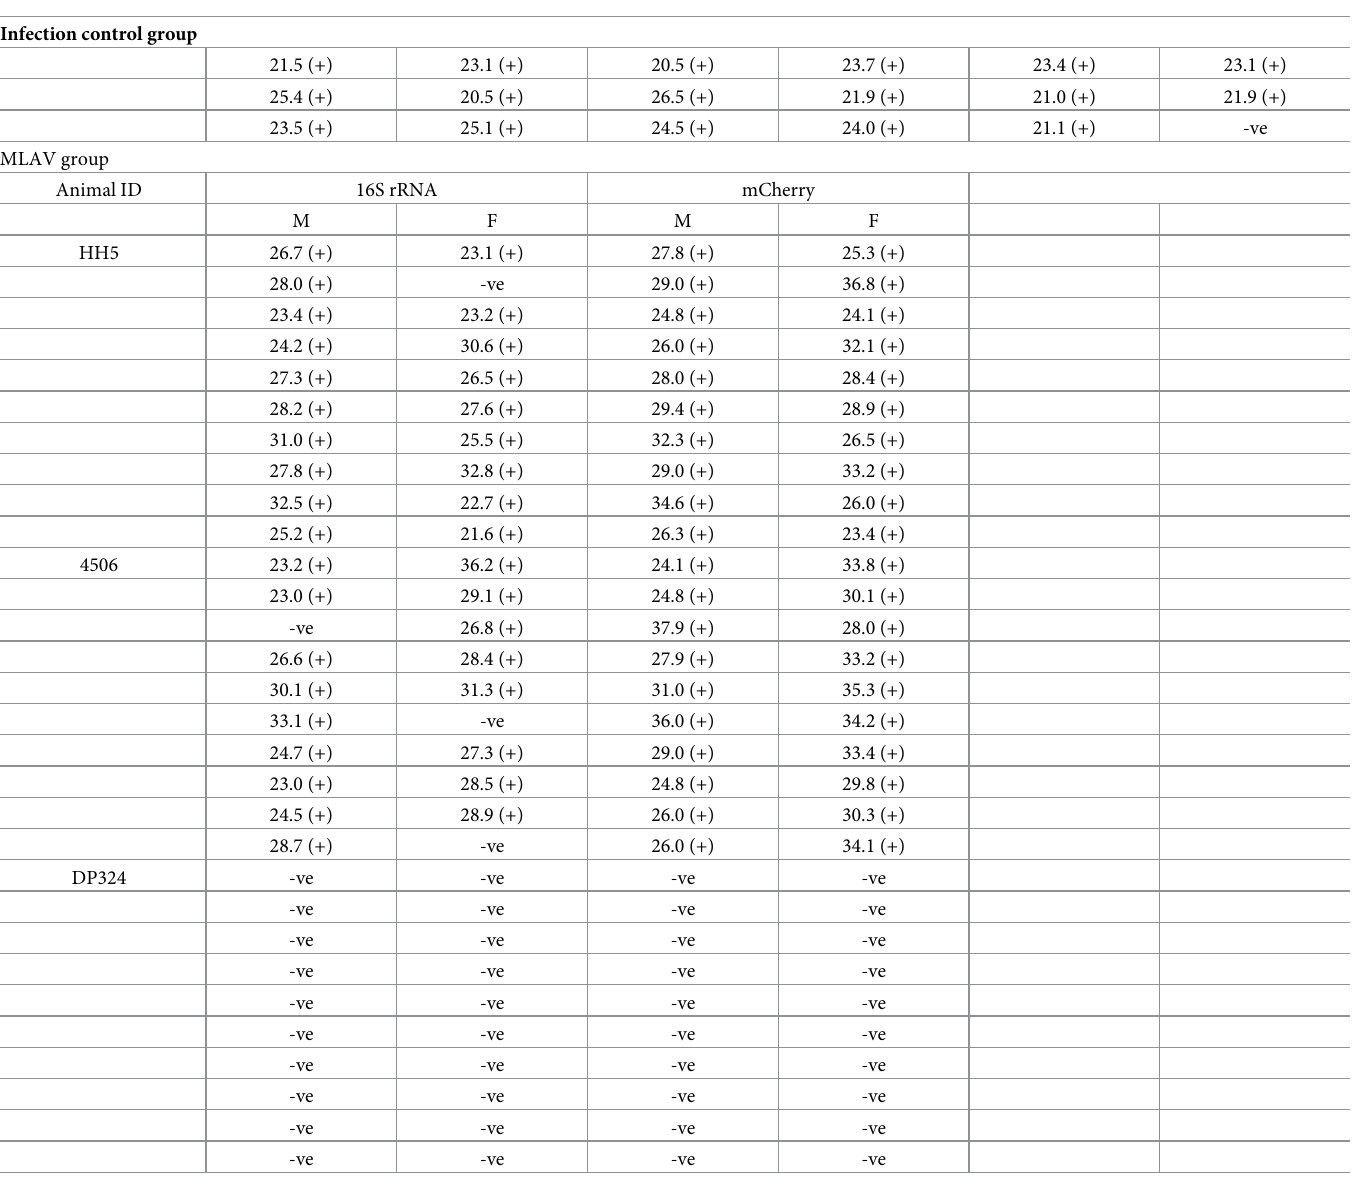
MLAV vaccinee, 40 additional ticks were tested; all of which also tested negative for A . margin- ale infection (not shown). The Ct values are considerably higher for the ticks fed on MLAV animals compared to infection control group and WCAV group animals. Most ticks from the two MLAV vaccinees had Ct values within the 2 cycles when comparing between 16S rDNA and mCherry gene target qPCR values, while few ticks had Ct values greater than 2 cycles for the mCherry gene-specific pPCR compared to the 16S rDNA gene-specific qPCR, suggesting that these ticks harbored both mutant and wild-type bacteria. Thus, we re-evaluated tick DNAs derived from the MLAV vaccinees by a conventional PCR assay targeting the regions upstream to the mutation insertion region with expected size amplicons of 2.4 kb and 3.4